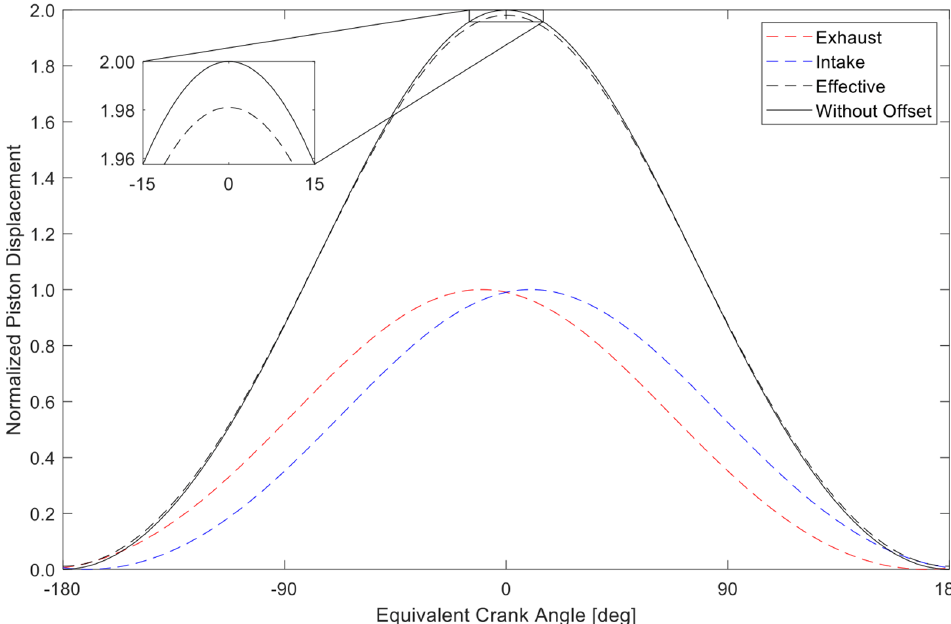
Figure 5. Instantaneous displacements of the (leading) exhaust (red) piston and the intake (blue) piston for the maximum crankshaft phase angle ϕ of 20°, and the resultant effective (inter-piston) stroke-normalized displacement (black), over an engine cycle. Inset: difference in effective displace- ment between minimum (0°, solid) and maximum (20°, broken line) crankshaft phase angle.